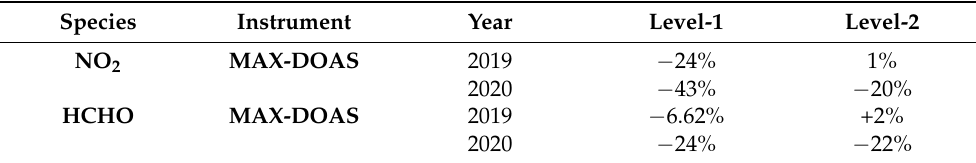
Table 3. Percentage change in mean VCDs of HCHO and NO 2 for Level-1 and Level-2 of the lockdown for 2020 and corresponding days in 2019.